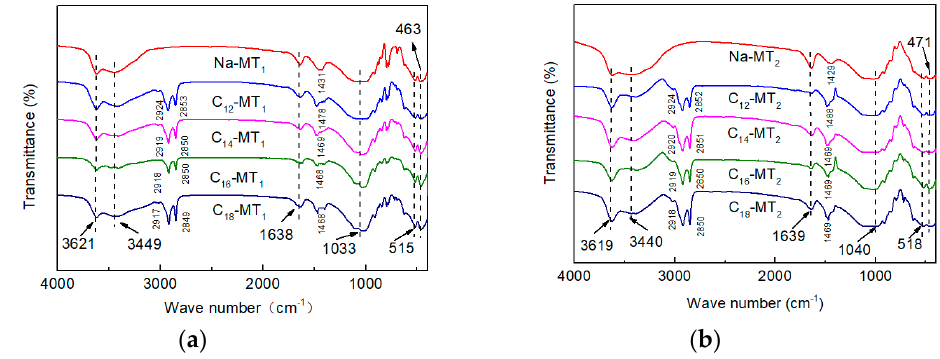
Figure 3. FTIR of Na-MT and prepared organo-MT, ( a ) MT1; ( b ) MT2.